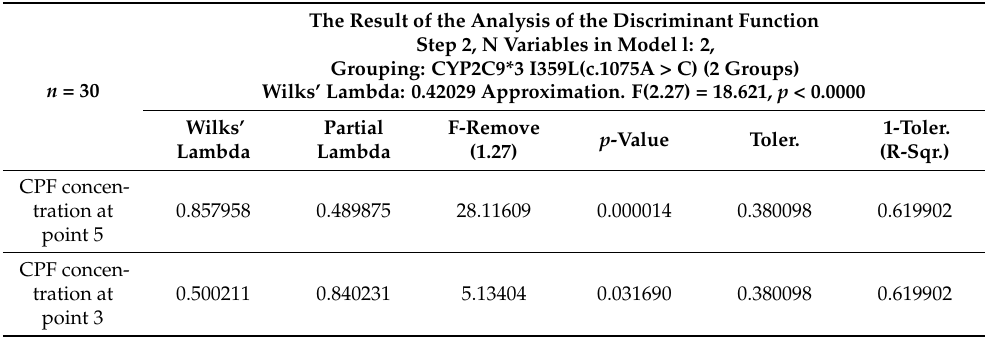
Table 6. The result of discriminant analysis with the dependent variable “CYP2C9*3 gene